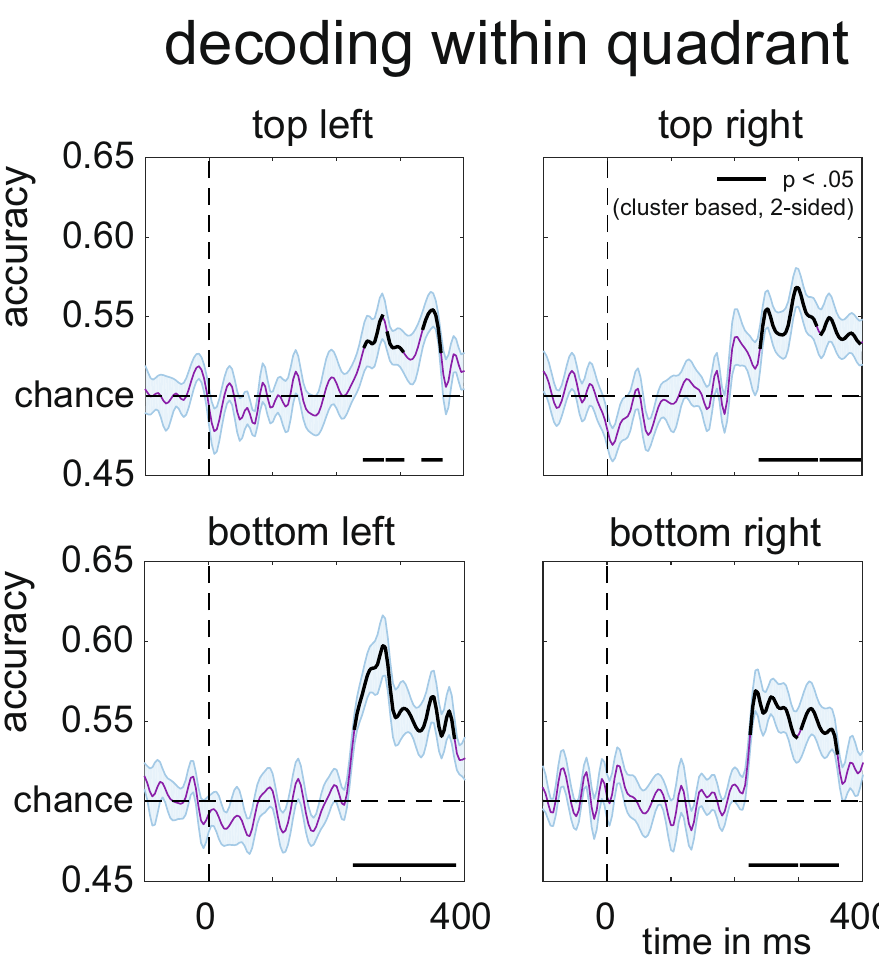
Figure 7. Per quadrant decoding accuracy of target position in Experiment 2. Black lines are corrected for multiple comparisons at p < 0.05 using cluster based permutation testing, two-tailed, see main text for exact cluster p-values. Shaded areas are + / −